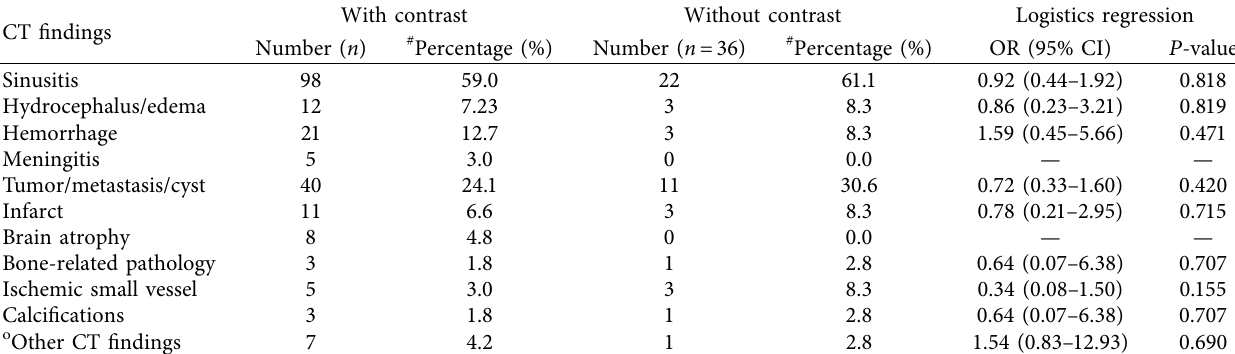
Figure 3: Distribution of patients with headache by classes of CT findings, 2017–2020. Table 3: Head CT findings and contrast enhancement among patients with headache, 2017–2020.